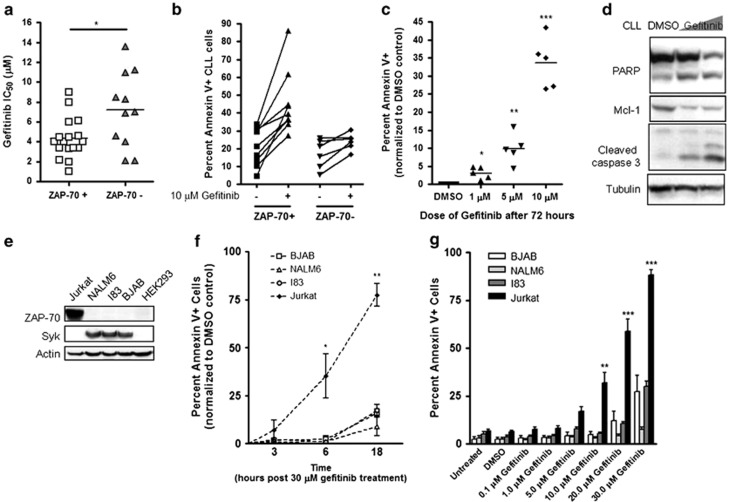
Gefitinib targets ZAP-70+ CLL cells. (a) Distribution of gefitinib IC50 values in ZAP-70+ (n=22 tested) or ZAP-70− (n=23 tested) patient samples after 24 h of treatment. Only values within tested range of 1–15 μM are shown; values outside tested range were excluded. (b) Percentage of annexin V+ CLL cells from ZAP-70+ or ZAP-70− patients treated for 24 h with 10 μM gefitinib. (c) Percentage of annexin V+ CLL cells from 5 different ZAP-70+ patients after 72 h of treatment with DMSO, and 1, 5, or 10 μM gefitinib. (d) Lysates were collected after 24 h of CLL cells treated with DMSO, 10 μM gefitinib, or 15 μM gefitinib. (e) Western blot with lysates of ZAP-70− and ZAP-70+ lymphoid cell lines compared with ZAP-70− and Syk− HEK293 cell lines. (f) Treatment of lymphoid cell lines with 30 μM gefitinib for 3, 6, and 18 h normalized to DMSO-treated control. Three independent experiments are shown with standard errors (paired t-test). (g) Lymphoid cell lines treated with 0.1 to 30.0 μM gefitinib for 24 h. Cell death analyzed by staining with Annexin V-FITC and 7AAD and analysis by flow cytometry. Three independent experiments are shown with standard errors (paired t-test). *P<0.05, **P<0.01, or ***P<0.001